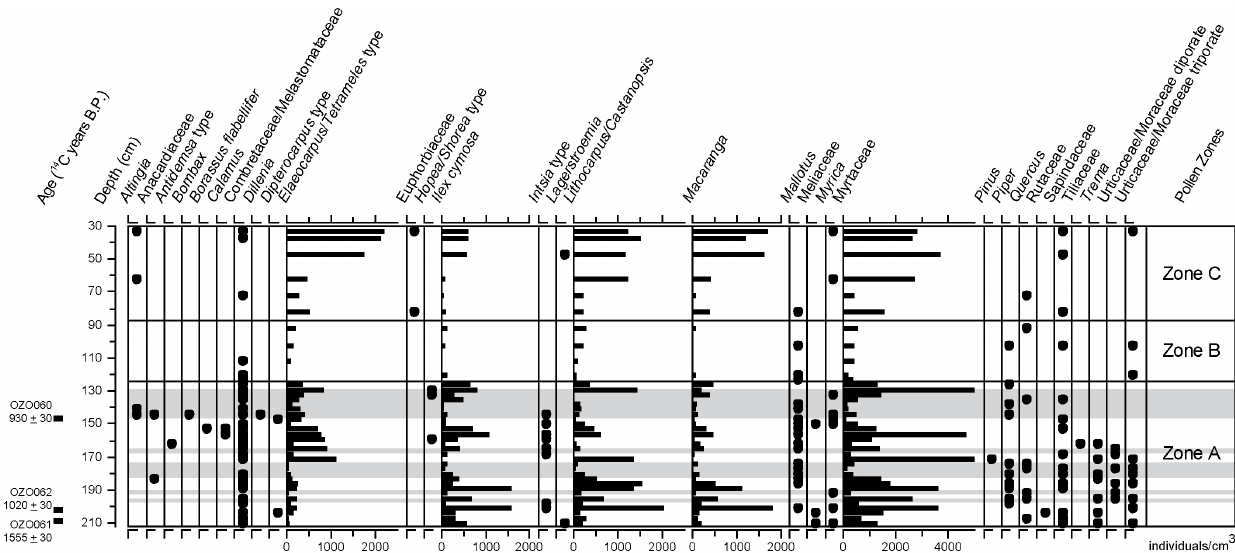
Figure 5. Pollen results (trees and shrubs). Concentration of pollen (individuals per cm 3 of sediment) from trees and shrubs, plotted against depth/age, for core TMR/B. Closed circles represent rare taxa that did not exceed 5% of the total microfossil assemblage in any sample. Light gray shading represents sand beds. Pollen zones based on classification of the whole assemblage. doi:10.1371/journal.pone.0084252.g005 PLOS ONE |